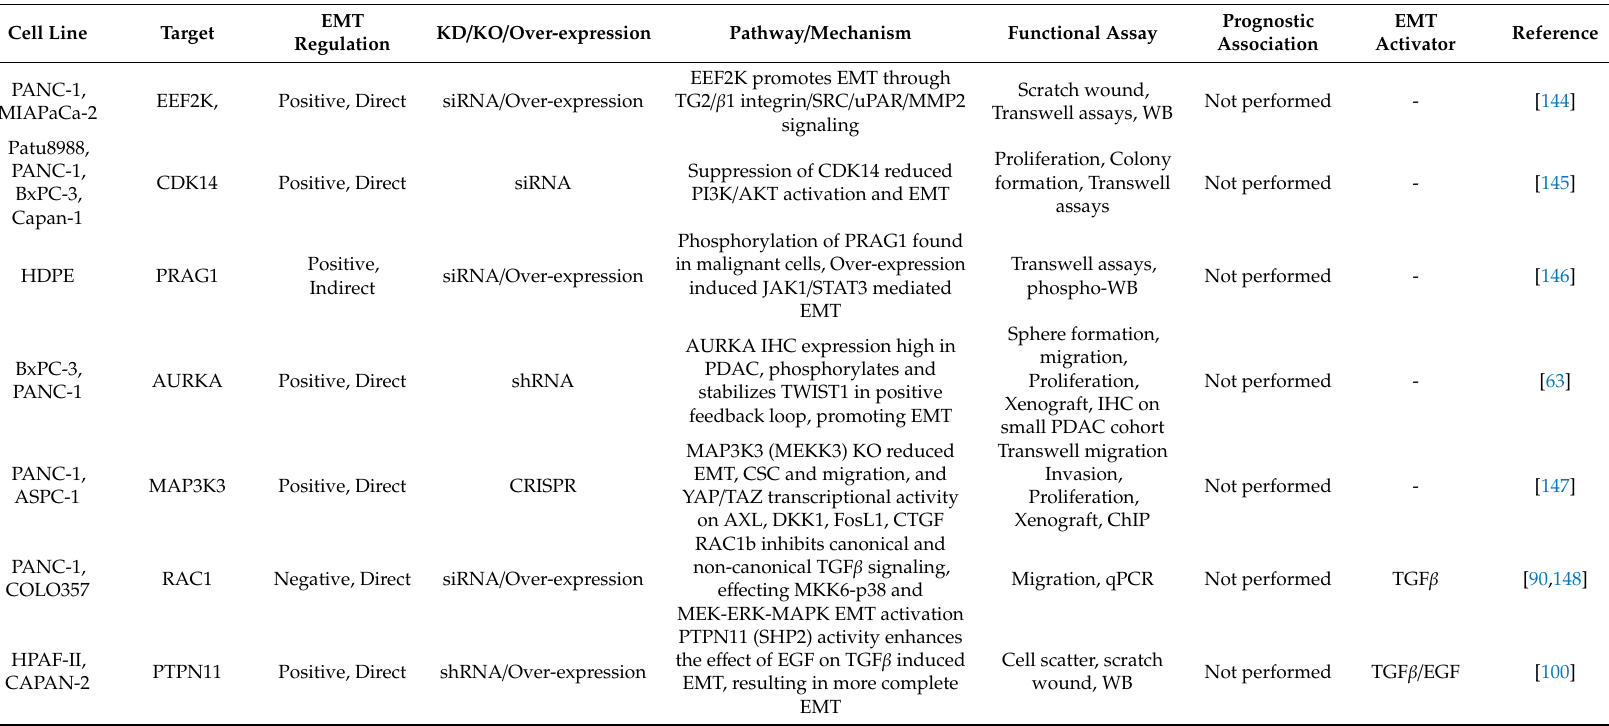
Table 5. Kinases and Phosphatases. This table describes proteins with activity that may directly participate in signal transduction by phospho-regulation of intracellular substrates. Candidates that exhibit clinical correlation with lymph node metastasis are shown in